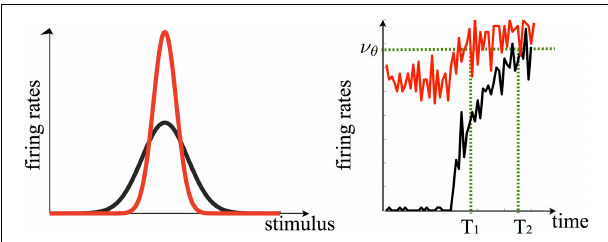
FIGURE 3 | In our model persistent delay activity is instrumental to both the suppression of activity of cells less selective to the sample and the enhancement of activity of those most selective to it. In this framework, the tuning curve of a given cell upon stimulus repetition is sharpened (red curve, left panel ). Note that in the original sharpening model the response to the cell’s preferred stimulus would not change upon repetition, i.e., the peaks of the red and black curve would overlap. The enhanced sharpening stems from persistent delay activity. The right panel shows how, following the sample offset, the population of cells which are mostly selective to it continues to fire persistently during the delay period (red curve to the left of the black dashed line, which indicates stimulus onset). Upon sample repetition, the population activity, starting off from a higher level with respect to the first presentation (black curve), ramps up faster–yielding the repetition enhancement effect- eventually reaching a recognition threshold ( ν θ ) faster ( T 1 < T 2 ). Curves are generated via the spiking neuron simulation in Tartaglia et al. (in